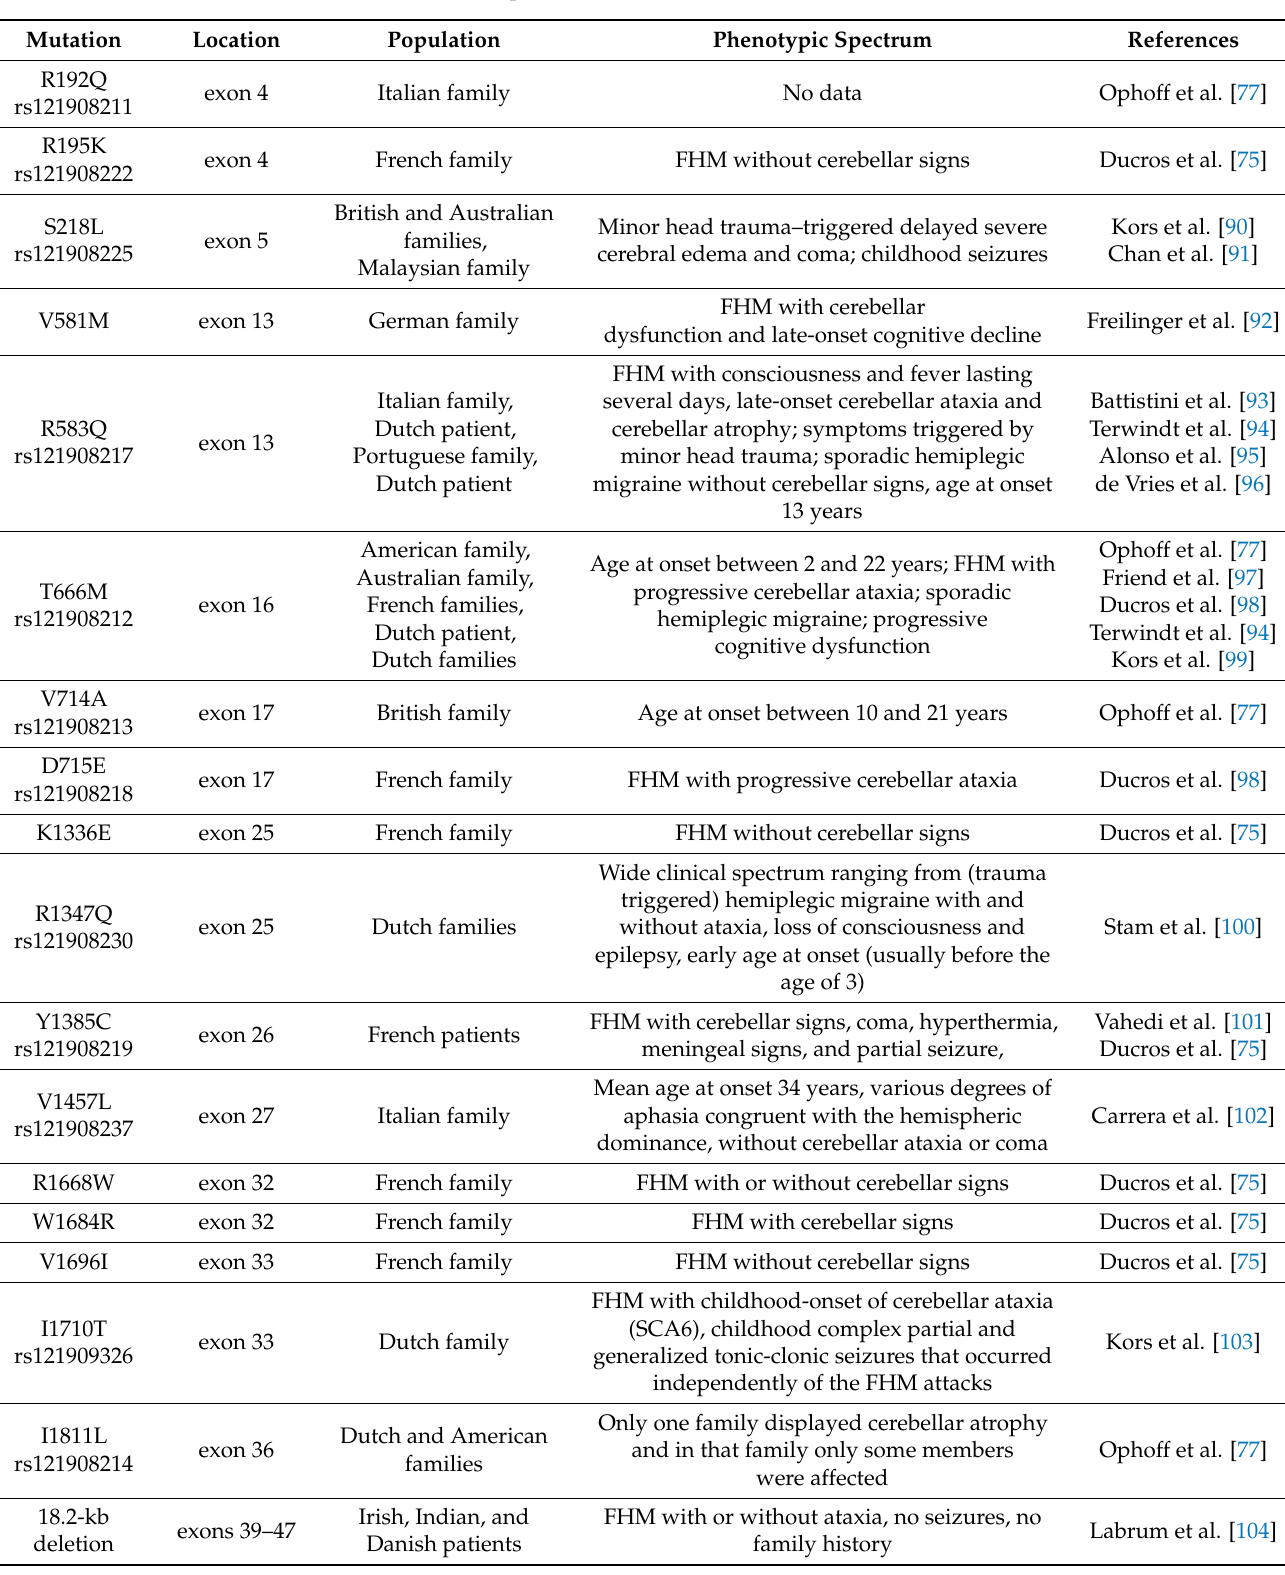
Table 1. Clinical presentation of CACNA1 mutation in